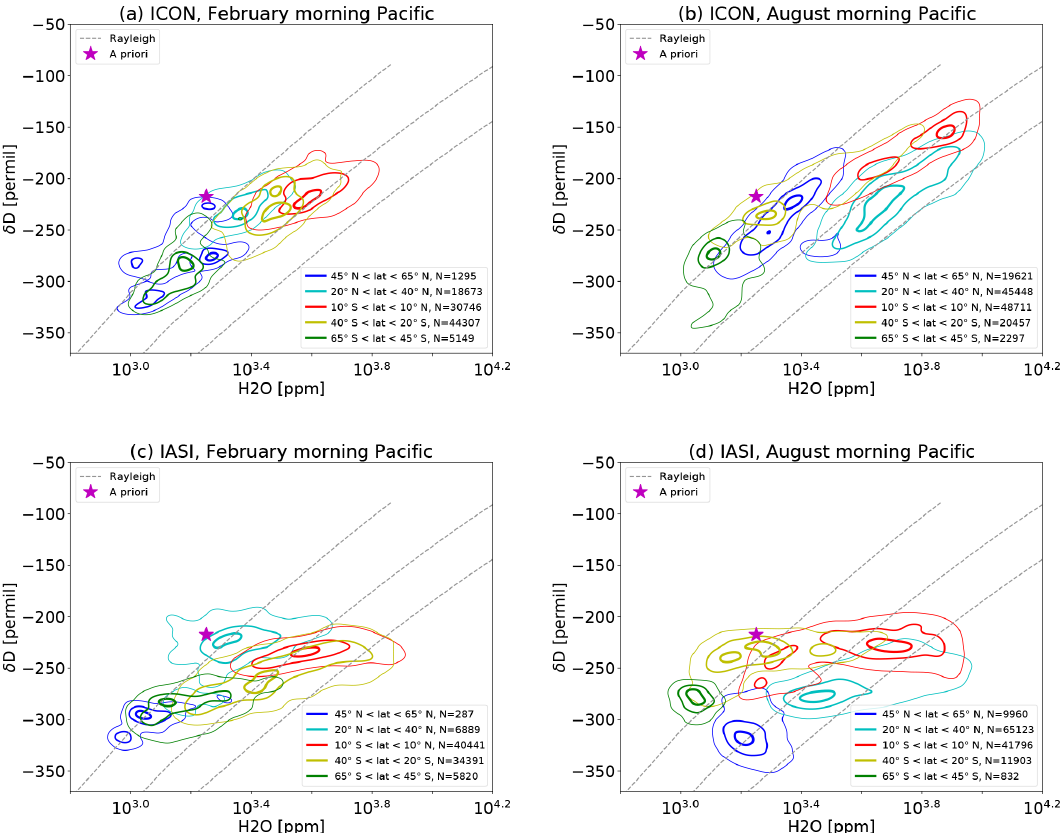
Figure 3. Isolines of the relative normalized frequency distribution for pairs of δ D and H 2 O (see Appendix A for the method) after processing ICON-ART-Iso data with the IASI retrieval simulator of Schneider et al. (2017) (a, b) and IASI data for the same time (c, d) . Data from morning overpasses are shown for 12 to 18 February (a, c) and 12 to 18 August (b, d) 2014 for different latitudinal bands over the Pacific Ocean (140 ◦ E < λ < 220 ◦ E longitude). Contour lines are indicated at 0.2, 0.6 and 0.9 of the normalized